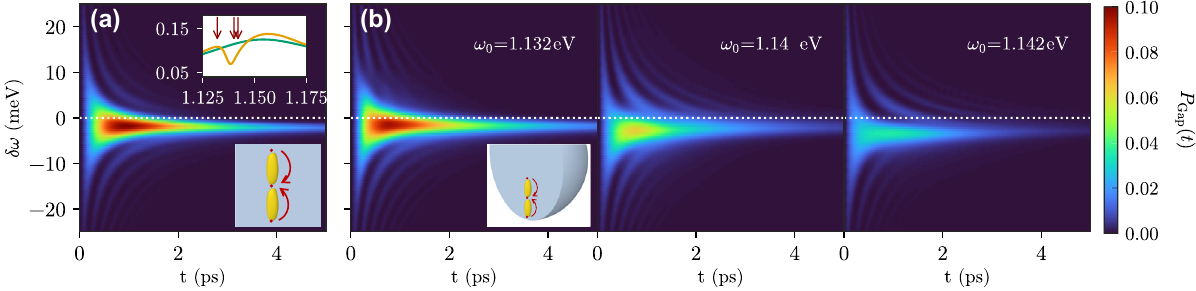
and Gap is detuned from that frequency. The initial 0